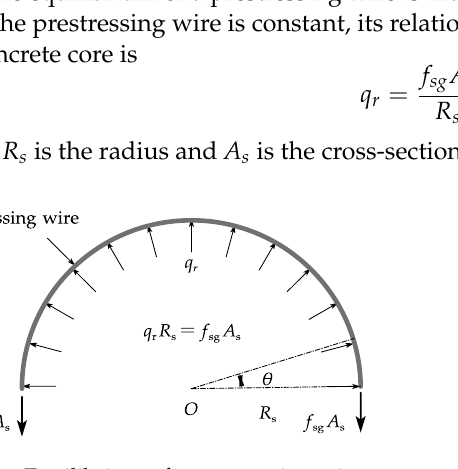
Figure 2. Equilibrium of a prestressing wire wrap.